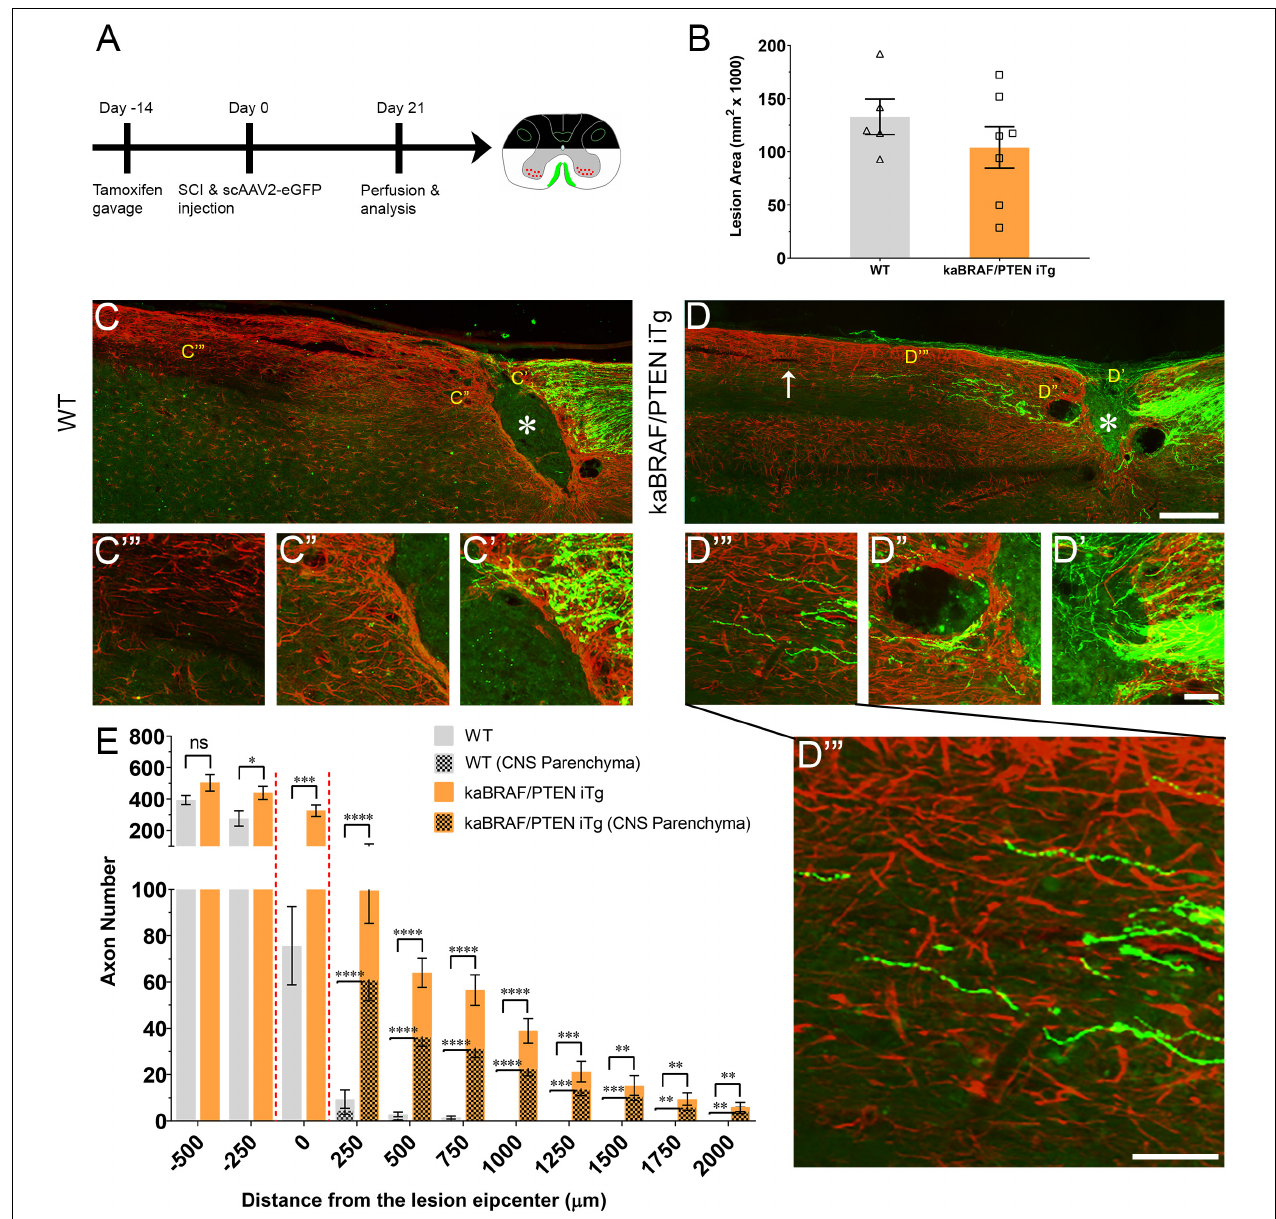
FIGURE 1 | Concomitant B-RAF activation and PTEN deletion promotes DC axon regeneration. (A) Schematic diagram showing the experimental timeline. Two weeks after the first tamoxifen gavage WT and kaBRAF/PTEN iTg mice underwent dorsal SCI and scAAV2-eGFP injection into the right lumbar (L) 4 and L5 DRGs to label regenerating DC axons. (B) Quantitative analysis of the lesion area after dorsal SCI in kaBRAF/PTEN iTg versus WT mice. (C–C (cid:48)(cid:48)(cid:48) ) Representative images of a WT mouse spinal cord showing most DC axons stopping at the caudal astroglial border of the injury site and very few growing along the astrocytic bridge that also terminates ∼ 200 µ m from the lesion epicenter. ∗ Indicates lesion epicenter. (D–D (cid:48)(cid:48)(cid:48) ) Representative images of a kaBRAF/PTEN iTg mouse spinal cord showing increased DC axon regeneration. Many regenerating DC axons penetrate the lesion epicenter; several extend directly across the rostral astroglial border of the injury site. ∗ Indicates lesion epicenter. (E) Quantitative analysis of total numbers of regenerated DC axons in kaBRAF/PTEN iTg versus WT mice. DC axon regeneration is significantly greater in kaBRAF/PTEN iTg mice at multiple distances measured from the lesion epicenter: –250 µ m: ∗ P = 0.0133, df = 10; 0 µ m: ∗∗∗ P = 0.0009, df = 10; 250 µ m: ∗∗∗∗ P < 0.0001, df = 10; 500 µ m: ∗∗∗∗ P < 0.0001, df = 10; 750 µ m: ∗∗∗∗ P < 0.0001, df = 10; 1,000 µ m: ∗∗∗∗ P < 0.0001, df = 10; 1,250 µ m: ∗∗∗ P = 0.0003, df = 10; 1,500 µ m: ∗∗ P = 0.0029, df = 10; 1,750 µ m: ∗∗ P = 0.0037, df = 10; 2,000 µ m: ∗∗ P = 0.0081, df = 10; two-way ANOVA with repeated measures. ∼ 75% of regenerating DC axons in kaBRAF/PTEN iTg mice enter the CNS parenchyma (the area with GFAP-positive astrocytes); the remaining 25% grow along the spinal cord surface. [ (E) patterned] Quantitative comparison of DC axons regenerated into CNS parenchyma in kaBRAF/PTEN iTg versus WT mice. Regenerating DC axons within CNS parenchyma are significantly increased at several distances rostral to the SCI in kaBRAF/PTEN iTg mice. 250 µ m: ∗∗∗∗ P < 0.0001, df = 10; 500 µ m: ∗∗∗∗ P < 0.0001, df = 10; 750 µ m: ∗∗∗∗ P < 0.0001, df = 10; 1,000 µ m: ∗∗∗∗ P < 0.0001, df = 10; 1,250 µ m: ∗∗∗ P = 0.0004, df = 10; 1,500 µ m: ∗∗∗ P = 0.0003, df = 10; 1,750 µ m: ∗∗ P = 0.0034, df = 10; 2,000 µ m: ∗∗ P = 0.0053, df = 10; two-way ANOVA with repeated measures. n = 5 (WT), and 7 (kaBRAF/PTEN iTg). Scale bars, 250 µ m (C,D) , 50 µ m (C (cid:48) –C (cid:48)(cid:48)(cid:48) ,D (cid:48) –D (cid:48)(cid:48)(cid:48) )